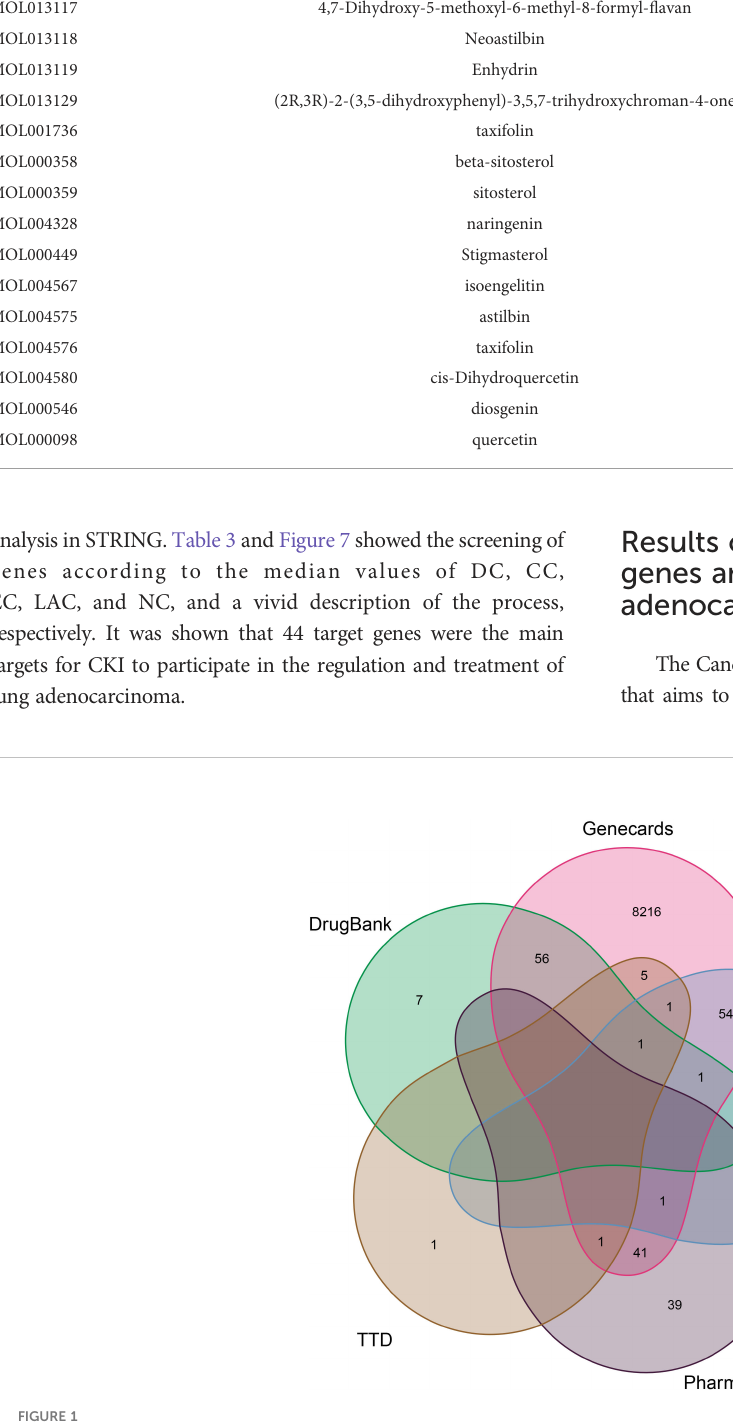
FIGURE 1 The Venn diagram of the distribution of different gene databases in lung adenocarcinoma. The number distribution of fi ve gene data banks of LUAD and takes the union of them. The red oval represents the identi fi ed Genecards compounds. The green oval represents the identi fi ed DrugBank compounds. The purple oval represents the identi fi ed PharmGkb compounds. The gray and blue ovals represent the TTD and OMIM compounds